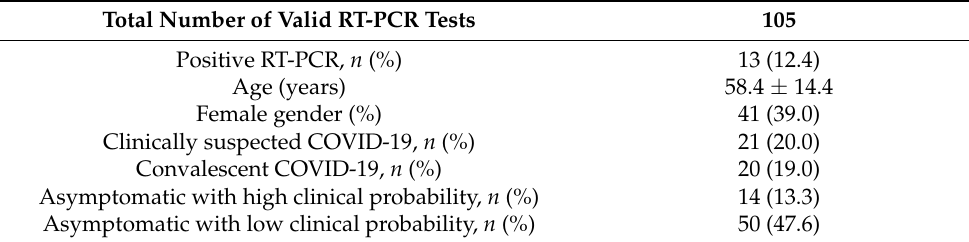
Table 1. Study cohort included in the validation study of the Inflammacheck ® device. Total Number of Valid RT-PCR Tests